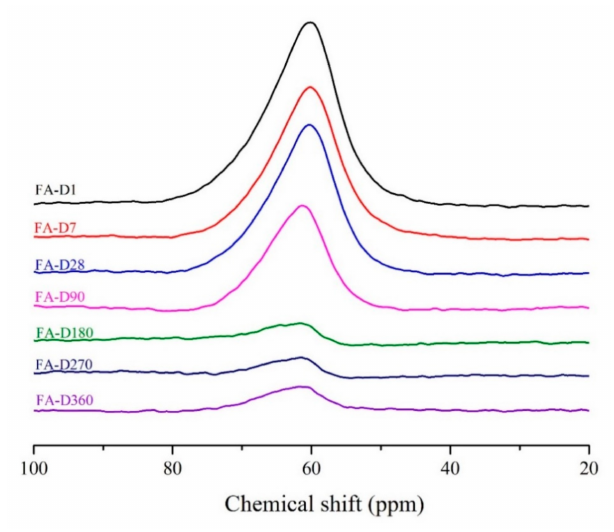
Figure 7. 27 Al nuclear magnetic resonance (NMR) spectra of the geopolymer pore solutions at ages between 1 day and 1